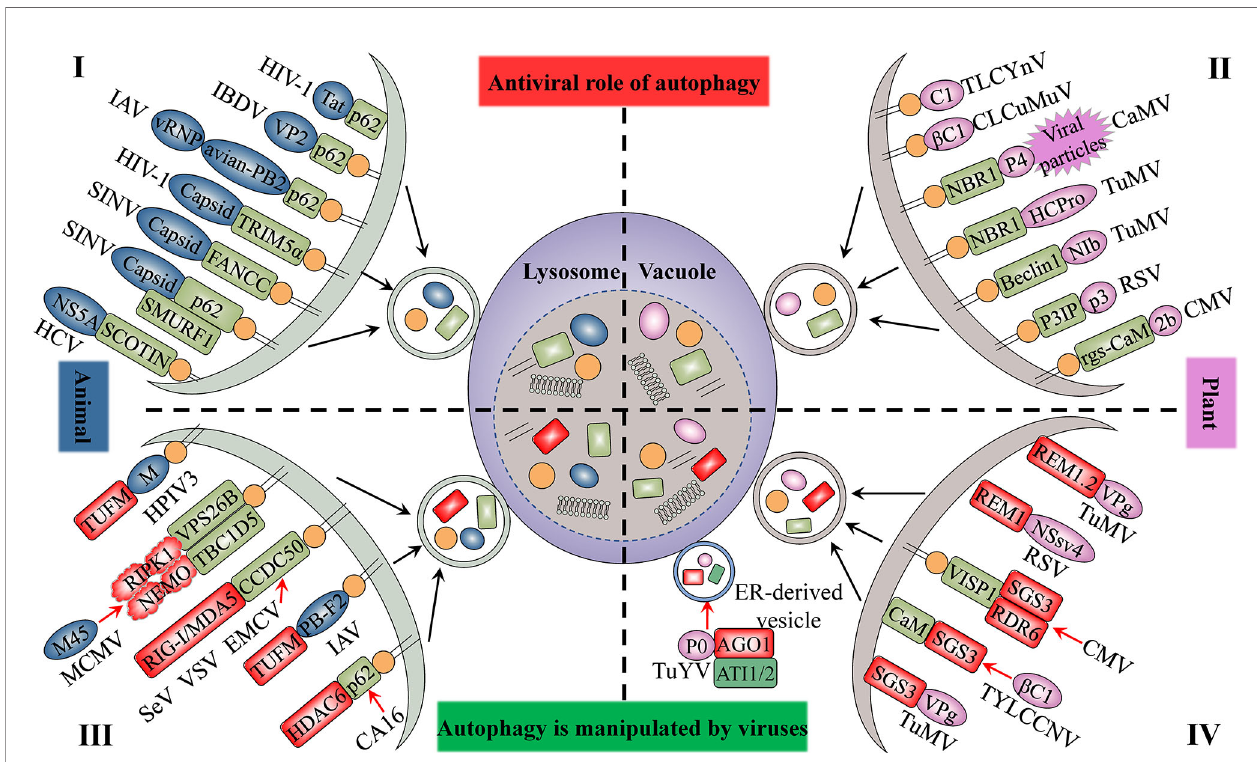
FIGURE 2 | The antiviral role of autophagy and its manipulation by viruses. The upper panel indicates the antiviral aspects of cellular autophagy (I and II). Viral proteins that manipulate host autophagy are shown in the lower part (III and IV). The left (I and III) and right (II and IV) parts represent the interaction of animal viruses and plant viruses with host autophagy, respectively. Selective autophagy mediated by cargo receptors is an antiviral mechanism common to both animal and plant cells. Viruses derived from both plants and animals hijack autophagy to degrade factors that positively regulate host immune responses to enhance their self- proliferation. Blue-grey ovals represent animal viral proteins. Plant viral proteins are shown in pink. The grass-green rectangle with rounded corners represents host selective autophagy cargo receptors. Factors that positively regulate host immune responses are displayed in red.